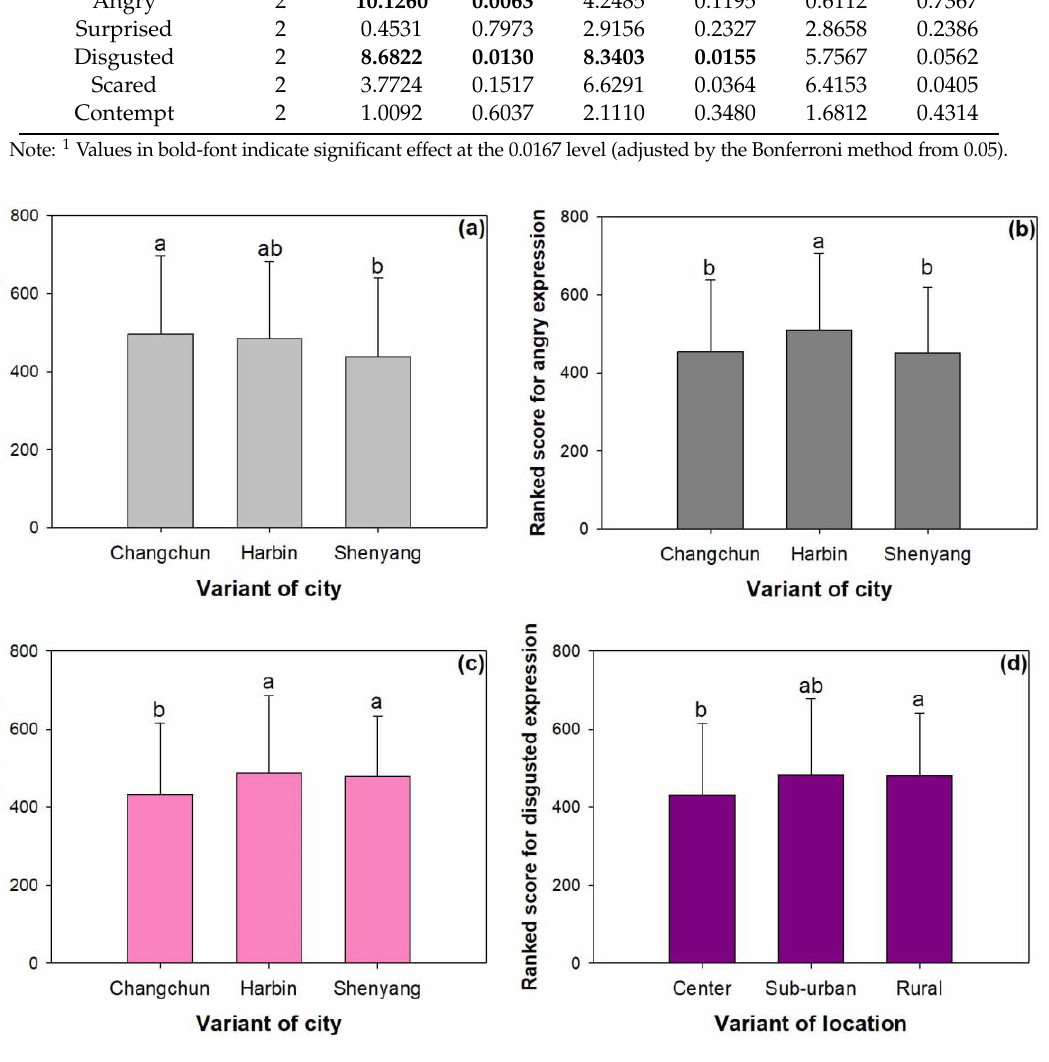
Figure 2. Ranked scores for neutral ( a ), angry ( b ), and disgusted ( c ) facial expressions among di ff erent cities and those for disgusted facial expression among di ff erent forest-park locations across cities ( d ). Di ff erent letters indicate significant di ff erence of ranked scores between any couple of the three comparisons according to Wilcoxon rank sum test at the 0.0167 level adjusted from the Bonferroni method. Error bars above columns indicate standard errors.